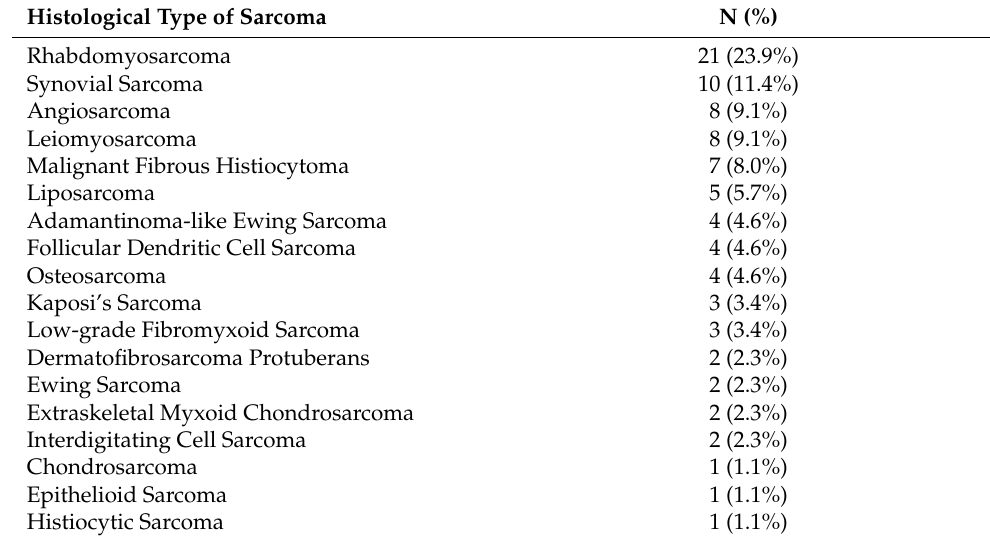
Table 3. Histological type of the parotid gland sarcomas included in this